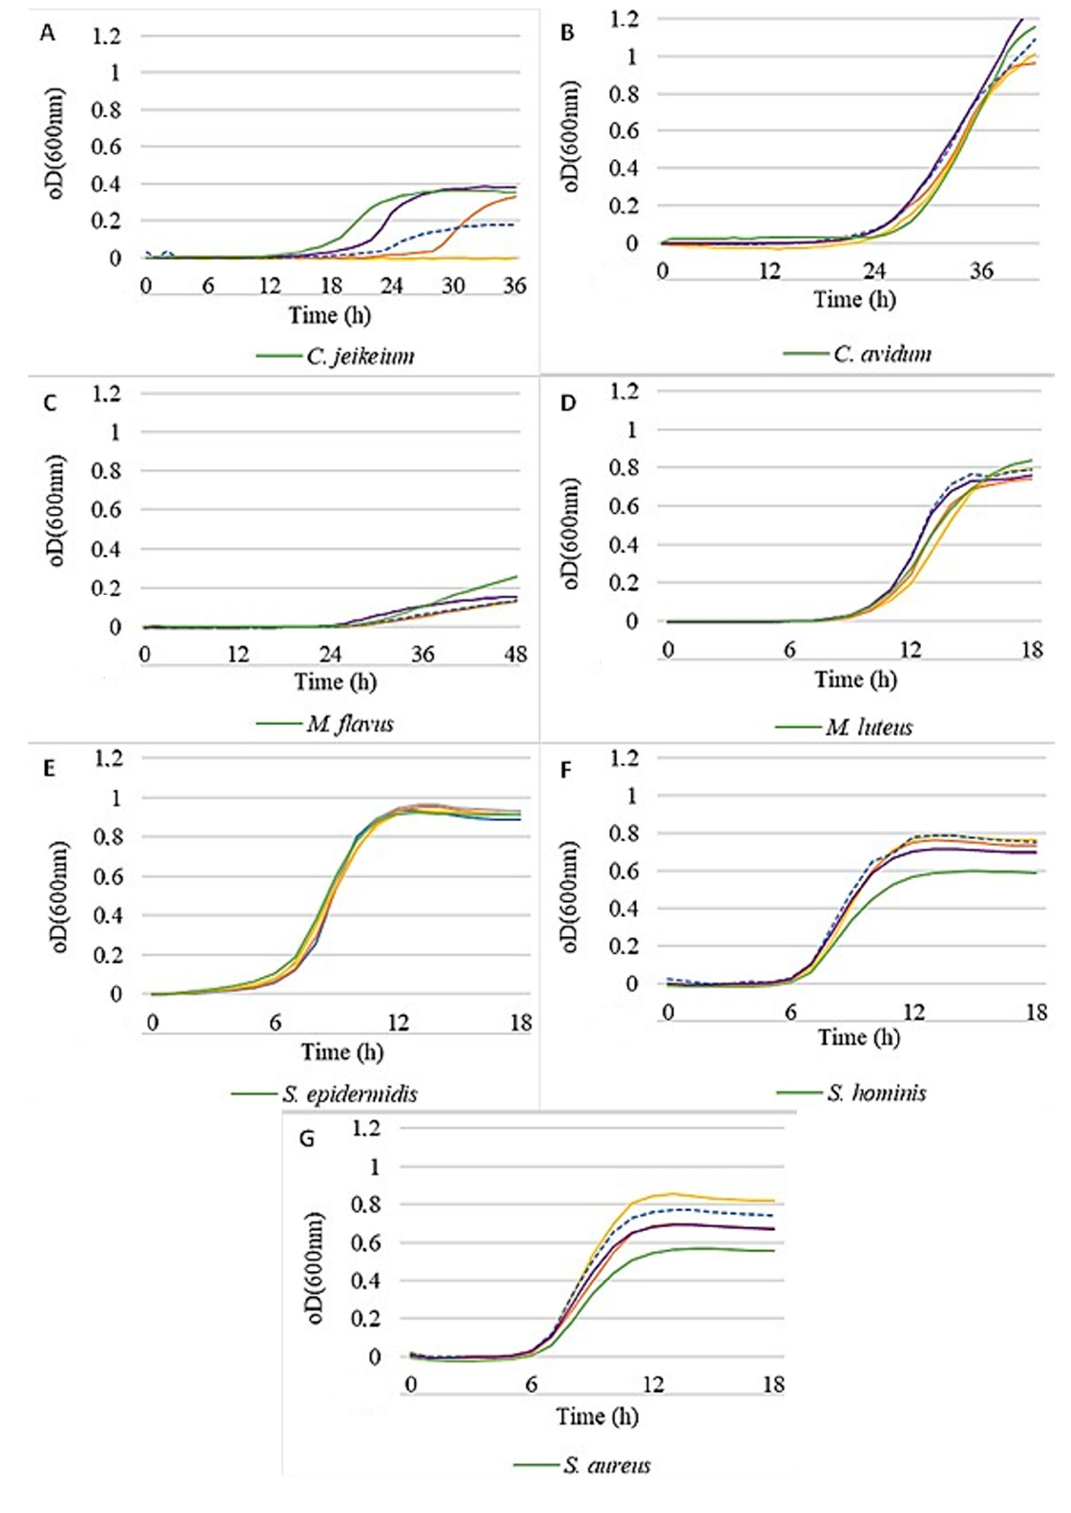
Figure 2. Growth curves for C. jeikeium ( A ), C. avidum ( B ), M. flavus ( C ), M. luteus ( D ), S. epidermidis ( E ), S. hominis ( F ) and S. aureus ( G ) with active 2 in different application concentrations. Yellow line: 4%, purple line: 2%, blue dotted line: 1%, red line: 0.5%, green line: control. Curves represent mean values of triplicates for each measurement.